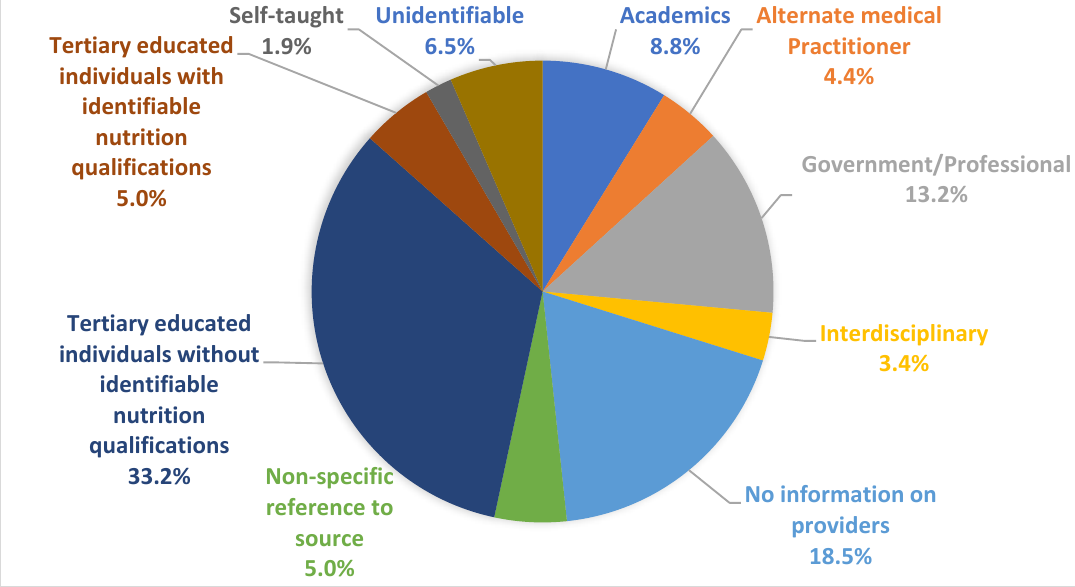
Figure 3. Results for provider vocational background.